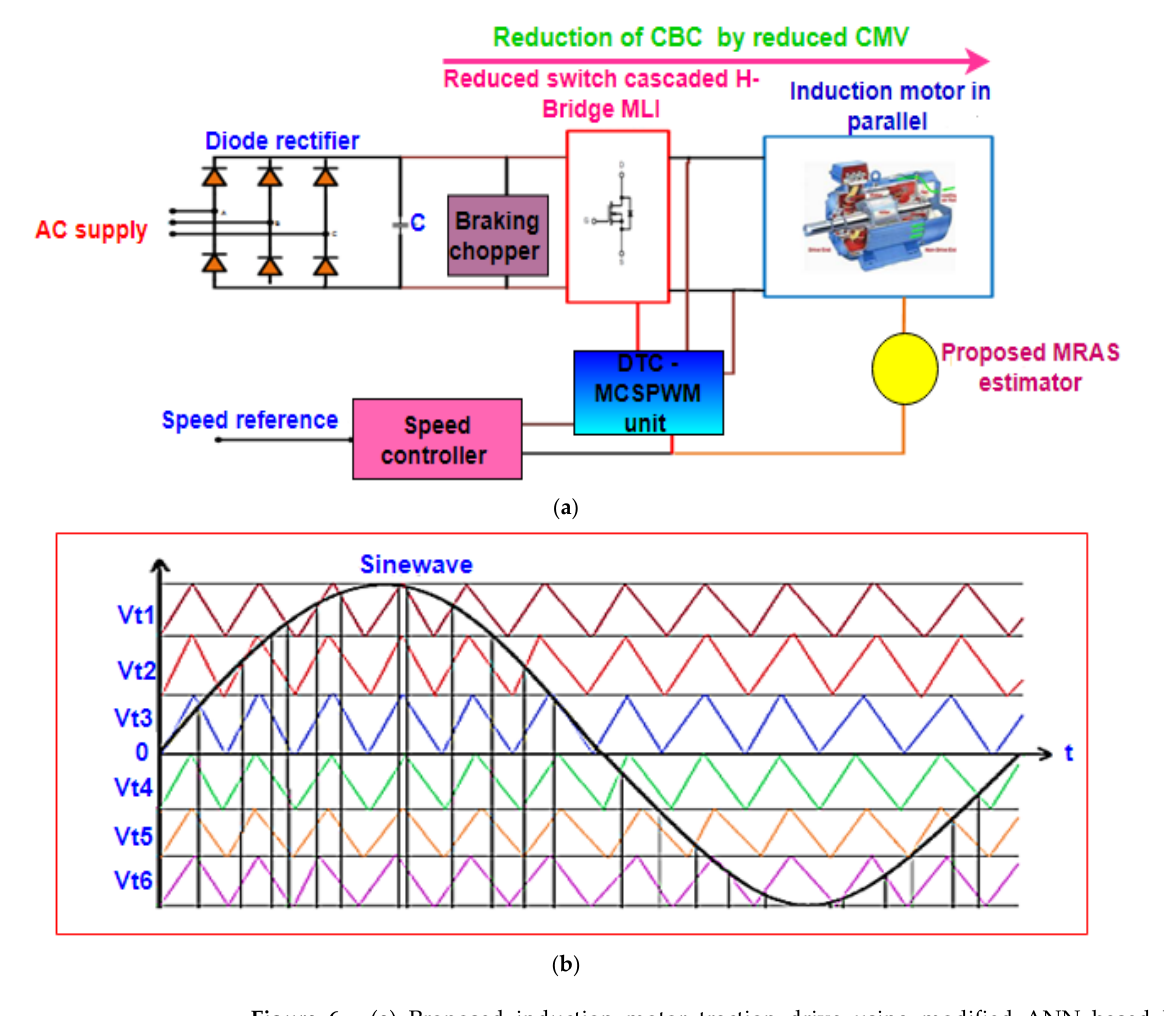
Figure 6. ( a )Proposed induction motor traction drive using modified ANN based MRAS ‐ methodol ‐ Figure 6. ( a ) Proposed induction motor traction drive using modified ANN based MRAS- ogy; ( b )multicarrier modulation scheme for five phases. methodology; ( b ) multicarrier modulation scheme for five phases.